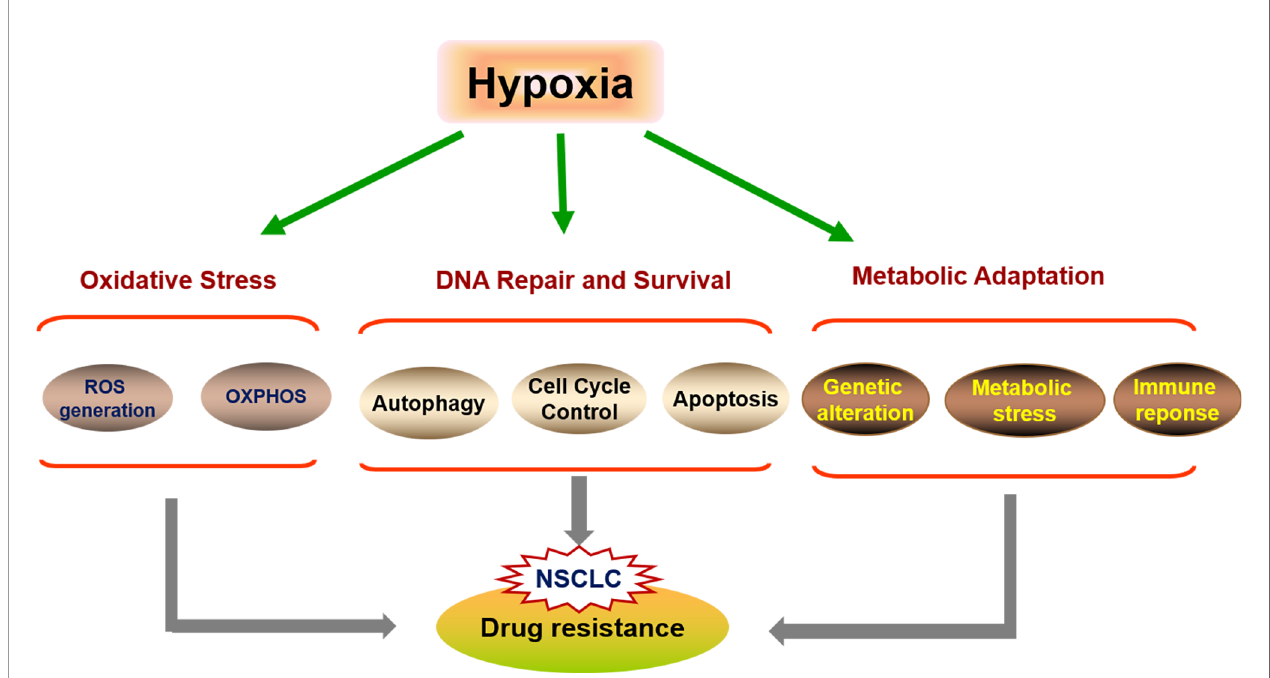
FIGURE 2 | The underlying mechanisms of hypoxia-induced drug-resistant NSCLC. Tumors exposed to hypoxia is an important mediator of resistance to cisplatin and EGFR-TKIs in NSCLC that induce apoptosis-resistant pathways by mediating autophagy and reducing susceptibility to apoptosis, and then metabolic adaptations in tumor cells to hypoxia leads to chemoresistance, which switches on genetic pathways and metabolic